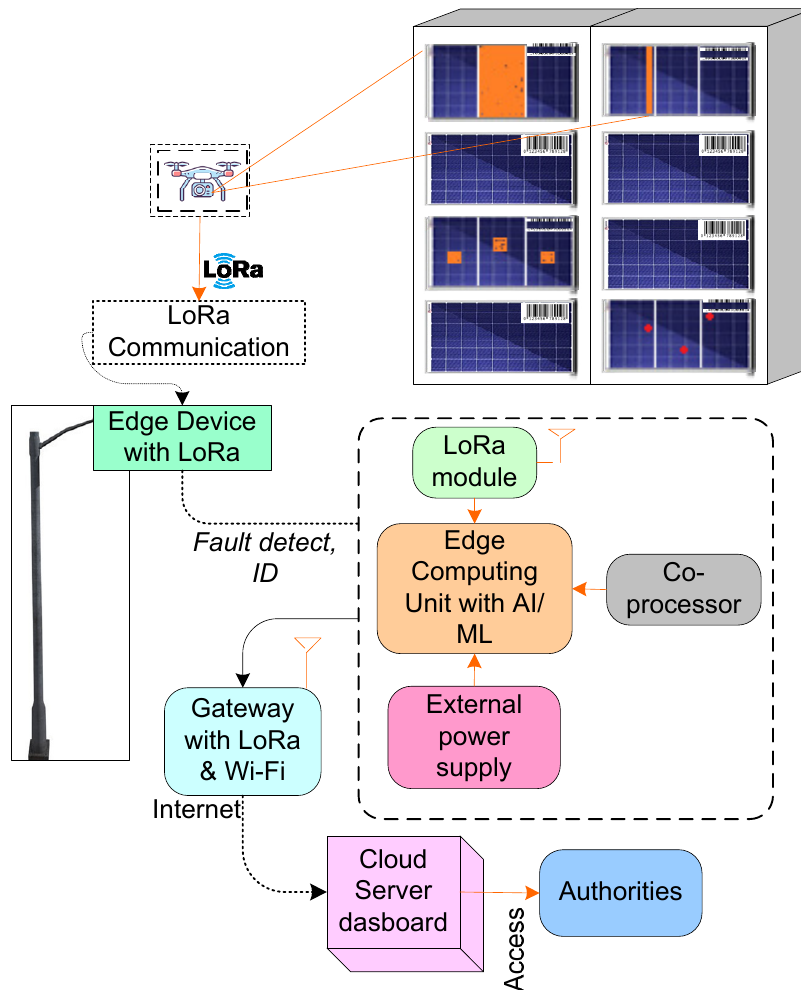
Figure 16. Proposed architecture for fault detection using edge computing with AI/ML.